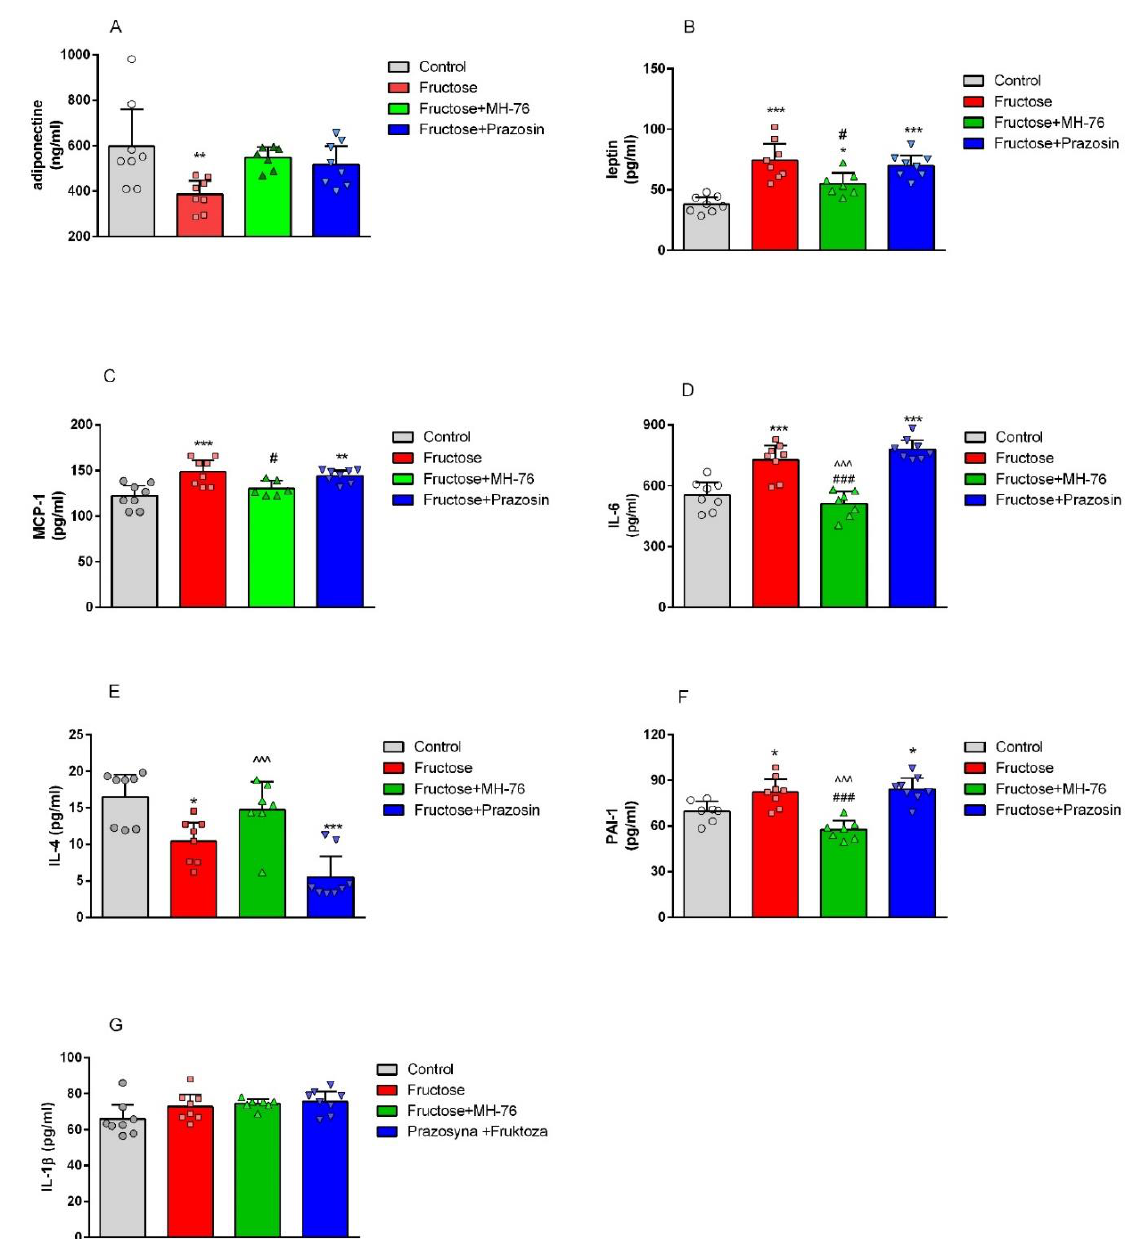
Figure 2. Effects of MH-76 (5 mg/kg i.p.) and prazosin (0.2 mg/kg i.p.) on adiponectin ( A ), leptin ( B ), MCP-1 ( C ), IL-6 ( D ), IL-4 ( E ), PAI-1 ( F ) and IL-1 β ( G ) concentration in fructose-fed rats adipose tissue. Data are expressed as means ± ∆ /2, where ∆ is a width of the 95% confidence interval (CI), (n = 6–8), * p < 0.05, ** p < 0.01, *** p < 0.001 vs. Control, # p < 0.05, ### p < 0.001 vs. Fructose, ˆˆˆ p < 0.001 vs. Fructose + Prazosin group (one-way ANOVA, post hoc Bonferroni multiple comparisons